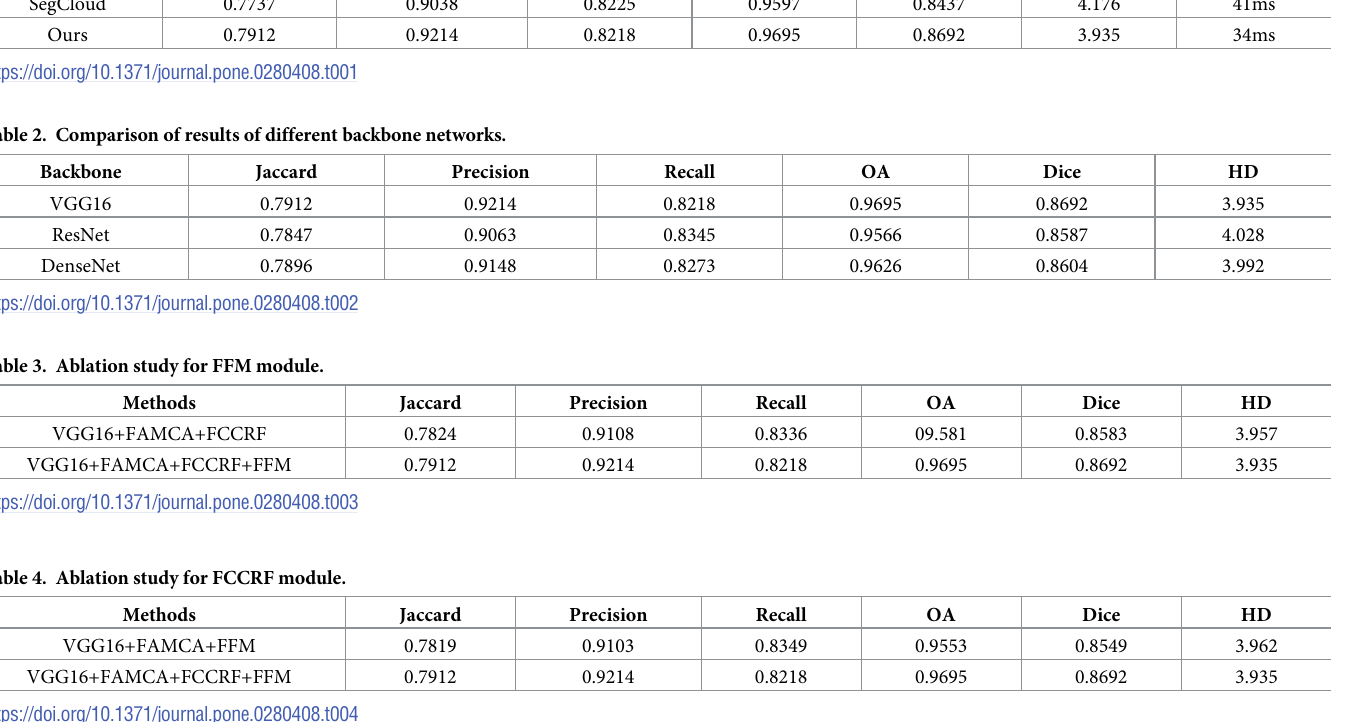
Table 1. Comparison of results with state-of-the-art satellite cloud image segmentation methods. Methods